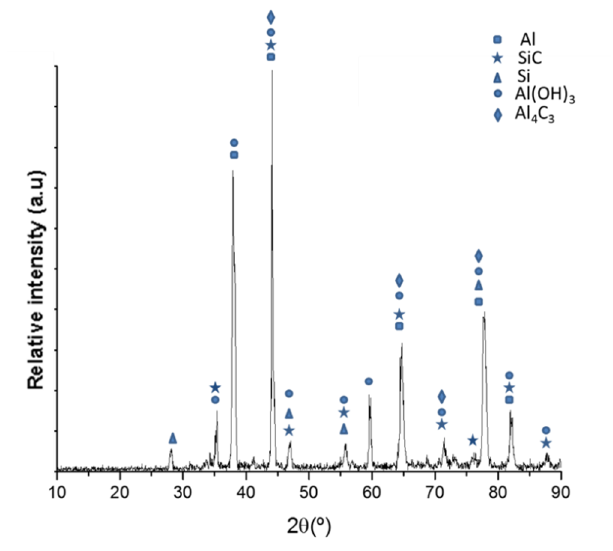
Figure 3. Al / SiCp X-ray di ff raction Figure 3. Al/SiCp X-ray diffraction pattern.